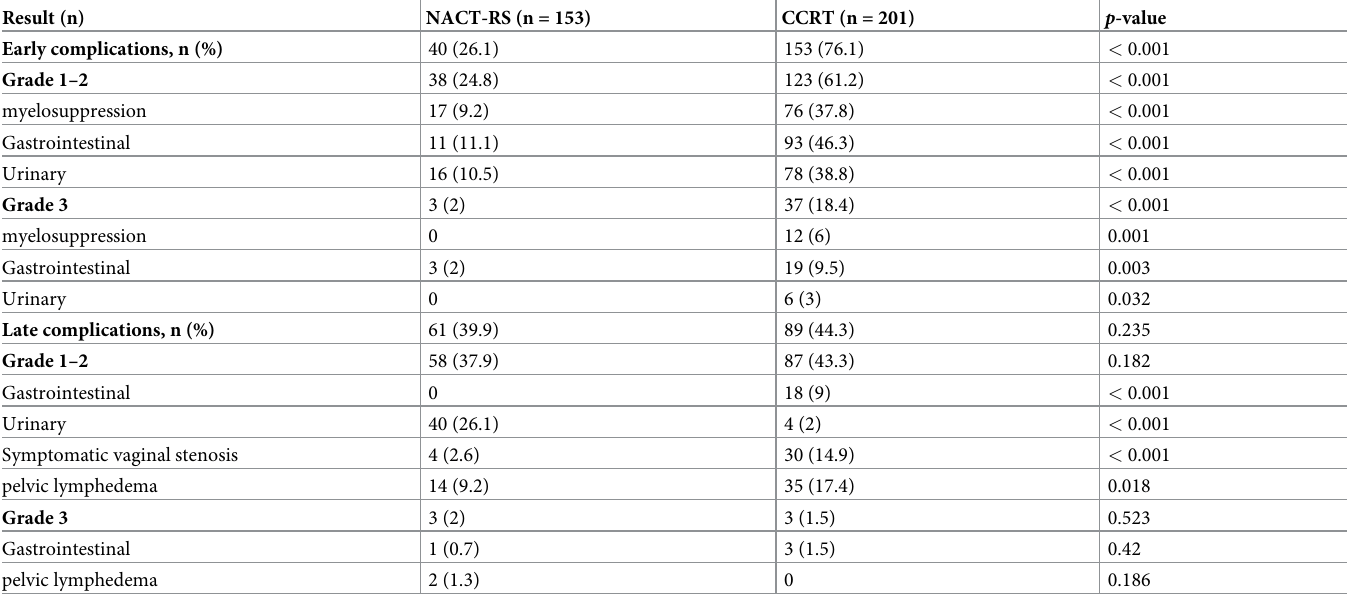
Table 3. Early and late complications according to the Chassagne